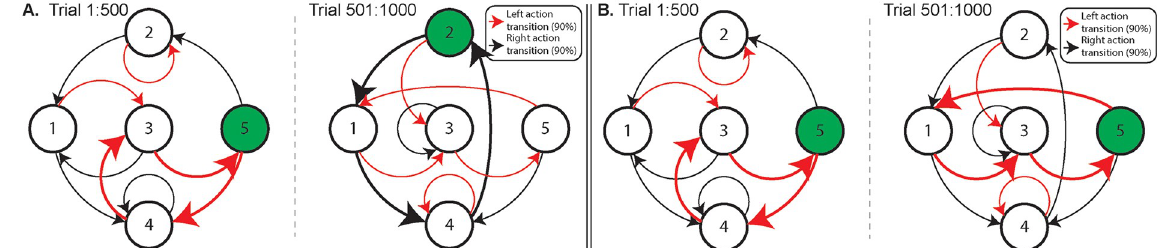
Fig 11. MDPs of experiment 1 (A) and 2 (B). Rewarded states are displayed in green. Each action had a probability of 90% to lead to the end state indicated by the red and black arrows (respectively left and right action). The remaining 10% transition probabilities were evenly distributed among the other states. For clarity, the thick arrows show the optimal path the agent should aim to take during the two contingencies. Note that the only difference between experiment (i) and (ii) is the location of the rewarded state after the CC (state 2 for (i) and 5 for (ii)).